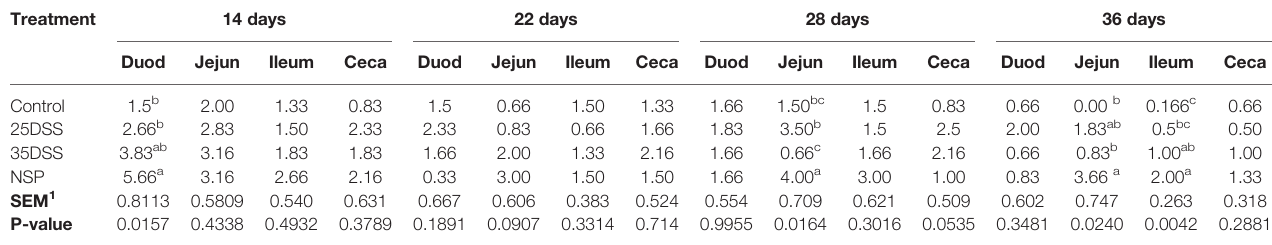
TABLE 5 | Macroscopically I See Inside lesions scores of duodenum (Duod), jejunum (Jejun), ileum and ceca of broilers submitted to different intestinal challenges at 14, 22, 28 and 36 days of age. The broilers challenged with DSS received 0.25mg/ml (25DSS) or 0.35mg/ml (35DSS) of DSS via oral gavage everyday from 9 to 14-d and 23 to 27-d; birds in the NSP treatment received a diet with 30% of rice bran during the whole experiment, and animals in the control group were not submitted to any challenge.